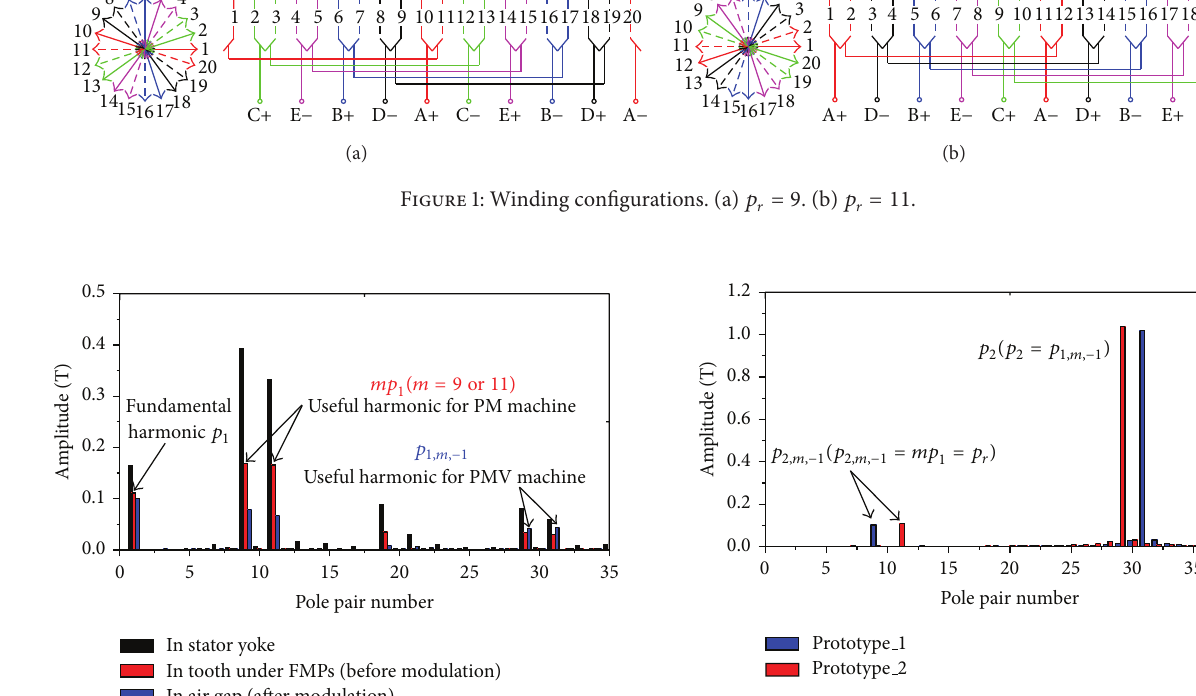
Figure 3: Space harmonic spectrum due to PMs.